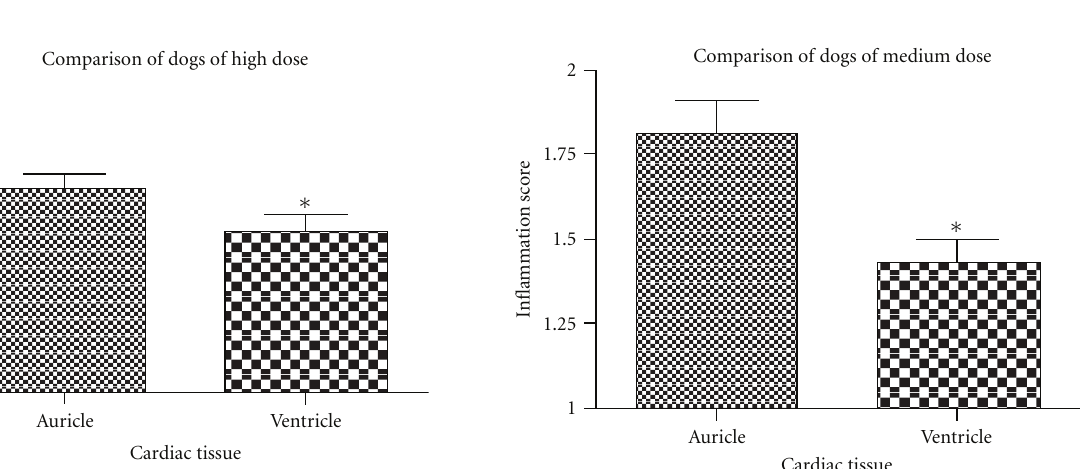
Figure 4: Auricular tissue also presents significantly more inflam- mation than ventricular at this dose ( P = 0 . 0032) and Mean + SEM is